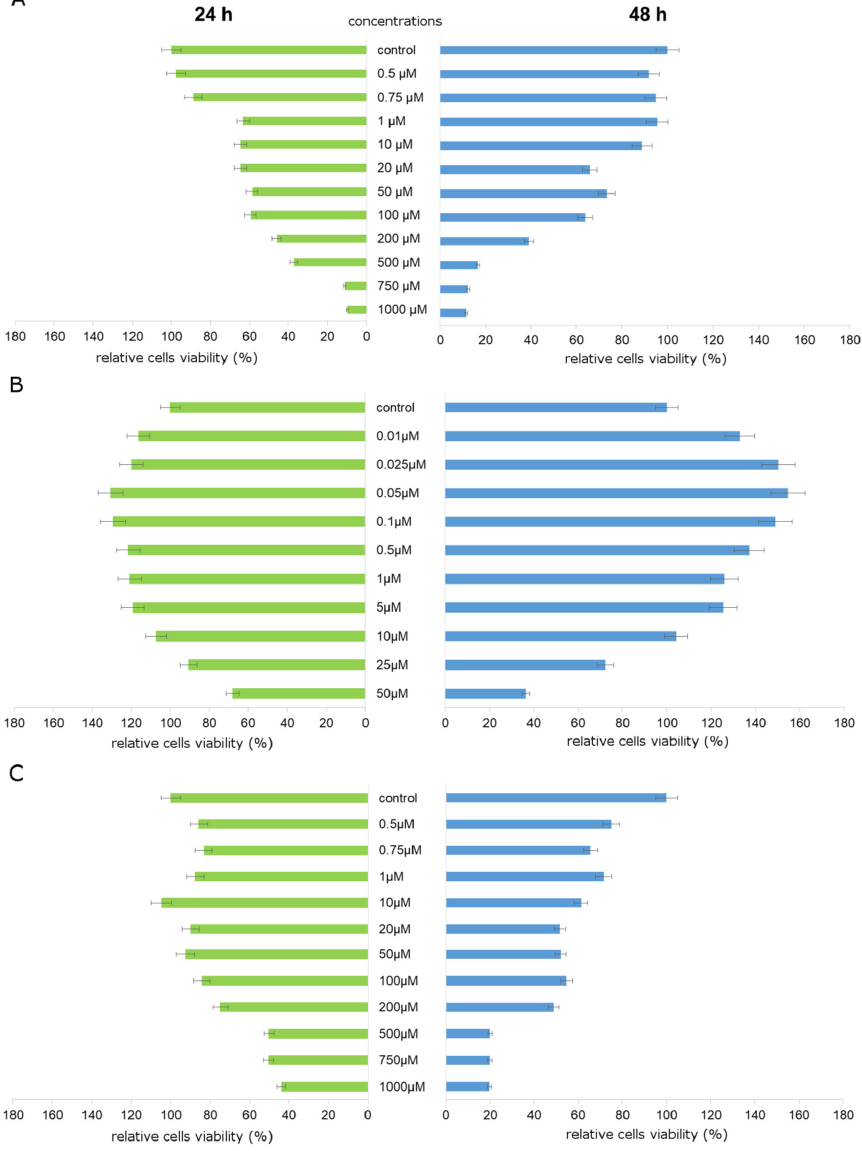
Figure 1. Relative cell viability. The ZR-75-1 cell line was exposed to ( A ) graded concentrations of TA (traumatic acid), ( B ) graded concentrations of Mes (mesotrione), and ( C ) graded concentrations of TA mixed with 0.05 µM of Mes. Mean values from three independent experiments ± standard deviation (SD) are shown.